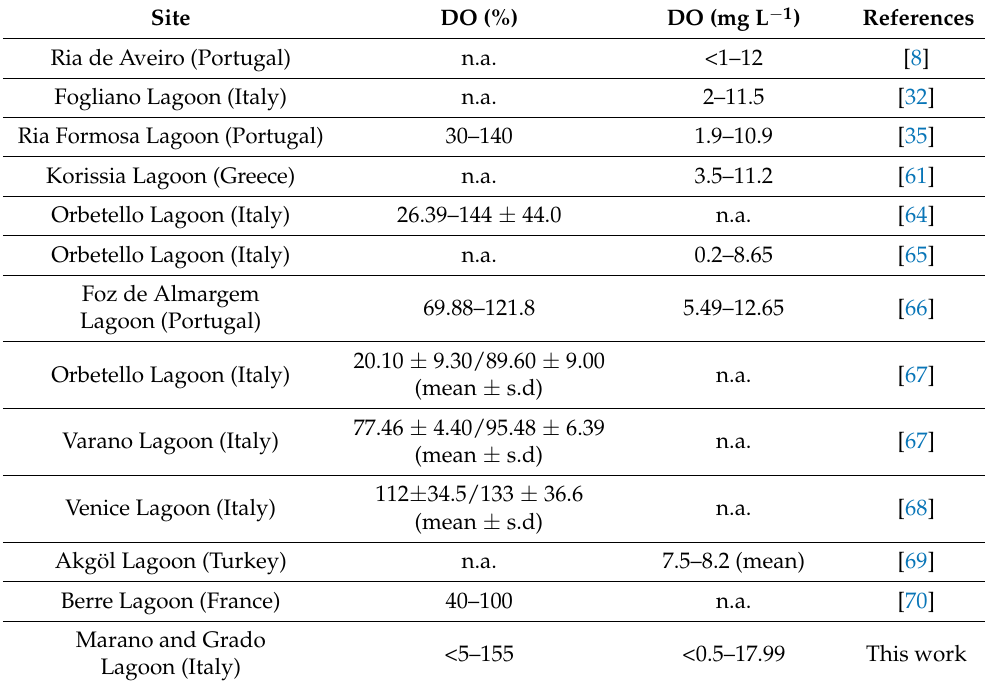
Table 1. Comparison of dissolved oxygen contents measured in some lagoons in the Mediterranean area. The notation n.a. means not